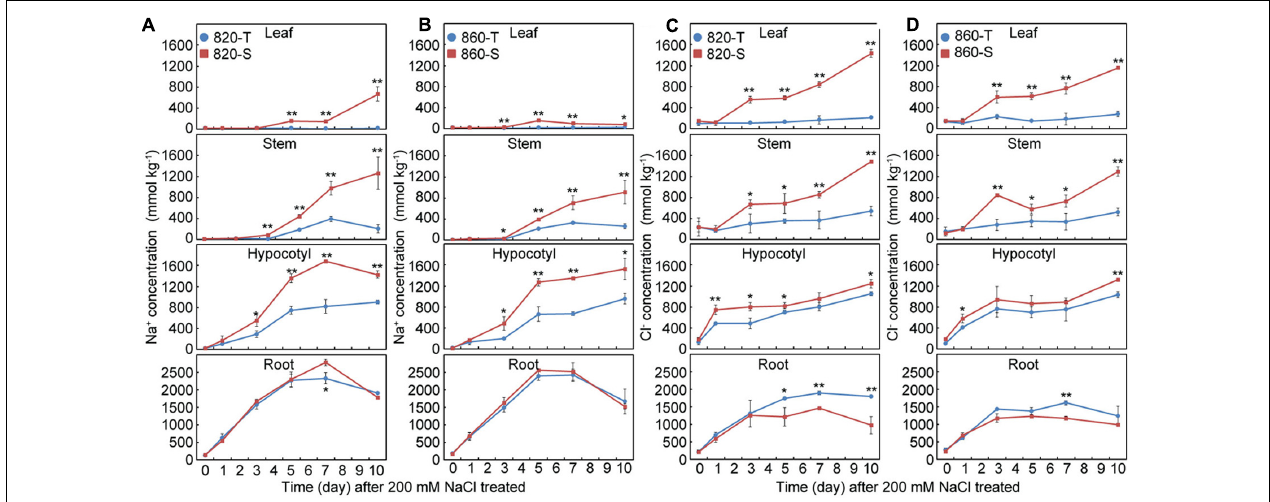
FIGURE 4 | Time-course of ion concentration (dry mass) in different tissues of NIL-820 and NIL-860 during 10 days of NaCl stress (200 mmol L − 1 ; EC = 17.8 dS m − 1 ). Na + concentration in leaf, stem, hypocotyl and root of NIL-820 (A) , and NIL-860 (B) , or Cl − concentration in leaves, stems, hypocotyls and roots of NIL-820 (C) , and NIL-860 (D) . Data are means of three replicates consisting of the mean values for five plants grown in the same pot ± SD. Student’s t -test was used to compare NIL-T and NIL-S at the same time point ( ∗ P < 0.05, ∗∗ P < 0.01).